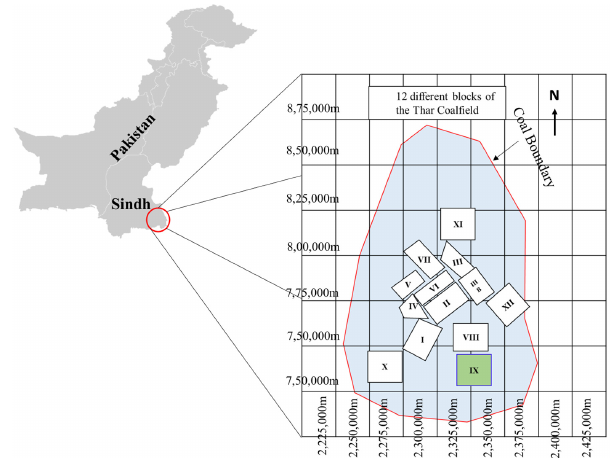
Figure 1. Geological site of the collected rock samples [38].